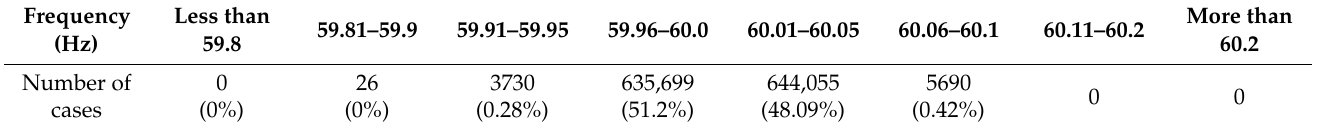
Table 1. Status of the frequency operation of the transmission system in South Korea